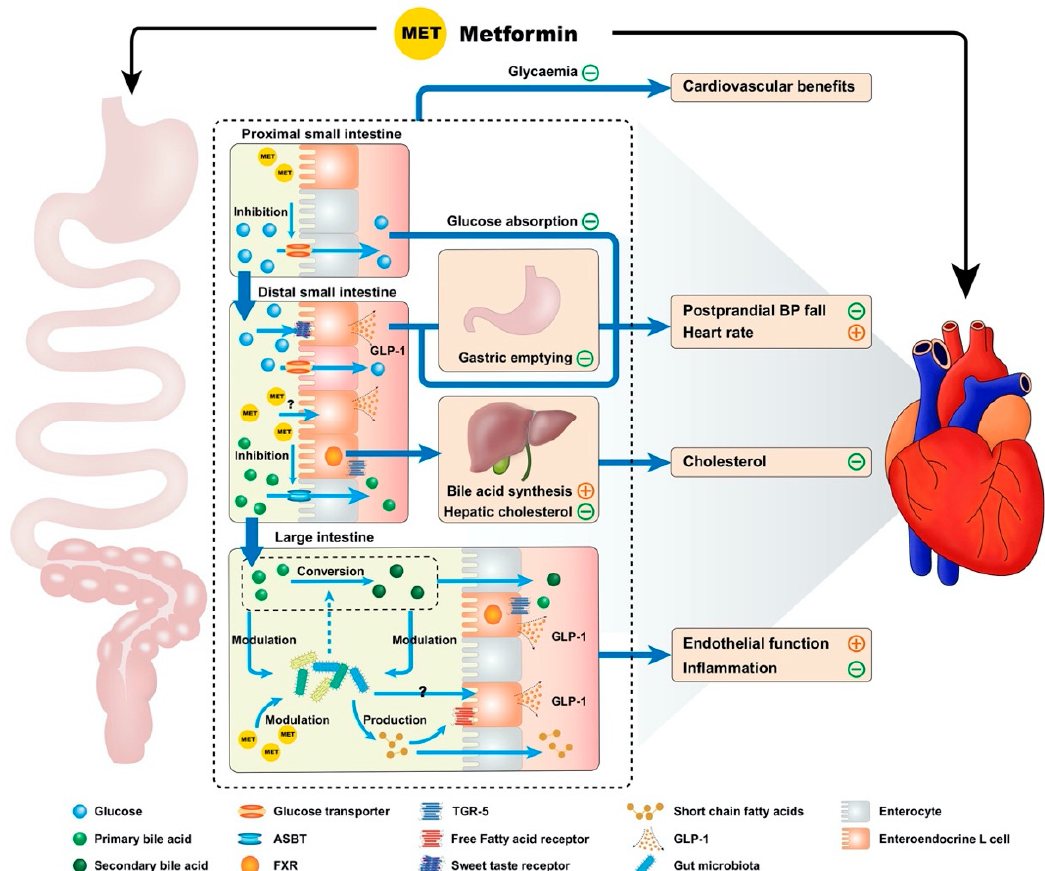
Figure 1. Proposed model by which metformin has cardiovascular actions via gastrointestinal mechanisms. Metformin potentially influences the cardiovascular system through multiple interconnected mechanisms derived from the drug’s interactions with the gastrointestinal tract. These include effects on intraintestinal bile acids (inhibition of resorption, reduction in hepatic low density lipoprotein cholesterol production secondary to reduced enterohepatic bile acid circulation and altered bile acid composition), modulation of the gut microbiota, reduction in the rate of small intestinal glucose absorption, enhanced glucagon-like peptide-1 (GLP-1) secretion and action and delayed gastric emptying. Many of these mechanisms would be expected to modulate the postprandial blood pressure (BP) response, providing a potential therapeutic option for the management of postprandial hypotension. Notable gastrointestinal receptors are referenced above, such as the apical sodium-dependent bile acid transporter (ASBT), farnesoid X receptor (FXR) and Takeda G-coupled receptor 5 (TGR-5).